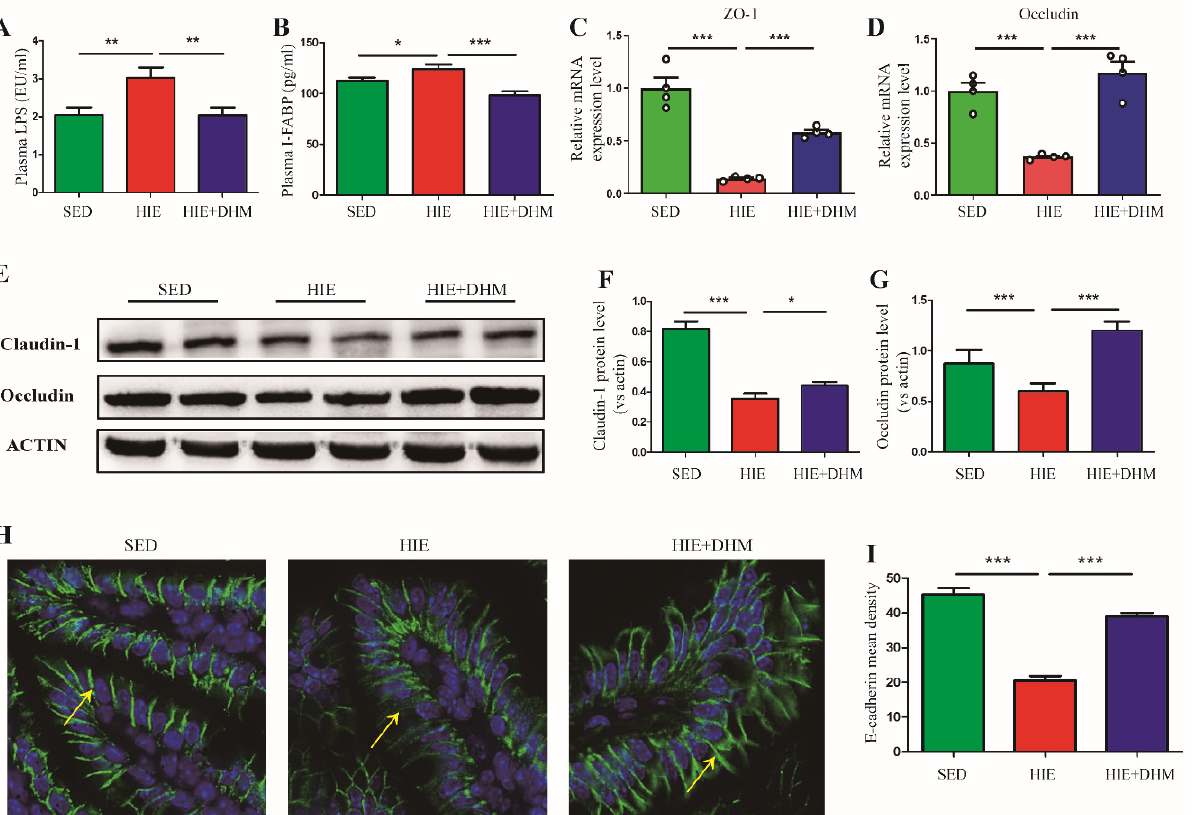
Figure 2. DHM maintains the intestinal barrier integrity and reduces endotoxemia in mice following high-intensity exercise. ( A ) The plasma LPS level was measured by the corresponding assay kit ( n = 8). ( B ) The plasma IFABP level was measured by the corresponding assay kit ( n = 6–8). ( C , D ) The relative mRNA expression levels of ZO-1 ( C ) and occludin ( D ) in small intestine tissues were detected by qRT-PCR assay ( n = 4). ( E ) The protein expression levels of claudin-1 and occludin were evaluated by Western blotting. ( F , G ) Relative protein levels of claudin-1 ( F ) and occludin ( G ) were quantified by densitometry ( n = 4). ( H ) Representative images of E-cadherin immunofluorescence staining in the small intestine among the three groups. Green fluorescence represents the expression of E-cadherin protein in the aggregated form (the yellow arrow), while the blue fluorescence with DAPI represents the cell nucleus. ( I ) The bar charts show quantification of fluorescence intensity ( n = 4). Data were expressed as means ± SEM. The experiments were replicated 2–3 times. The data shown were from one representative experiment, * p < 0.05, ** p < 0.01 and *** p < 0.001. Multiple groups were tested by one-way ANOVA followed by Bonferroni’s post hoc